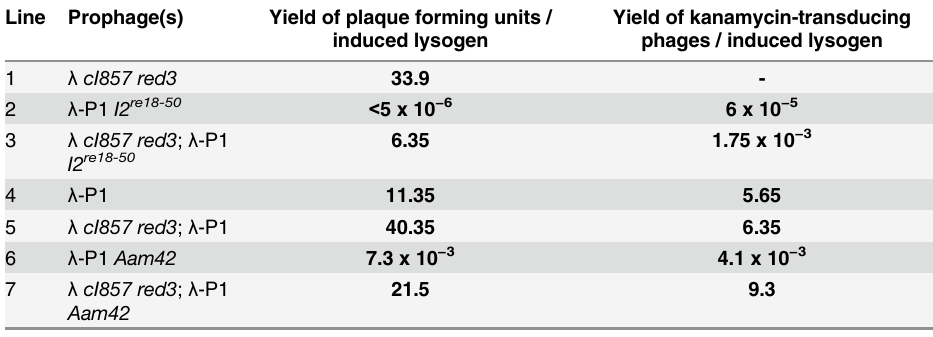
Table 1. The I2 re18-50 mutation is cis -specific. Line Prophage(s) Yield of plaque forming units / induced lysogen